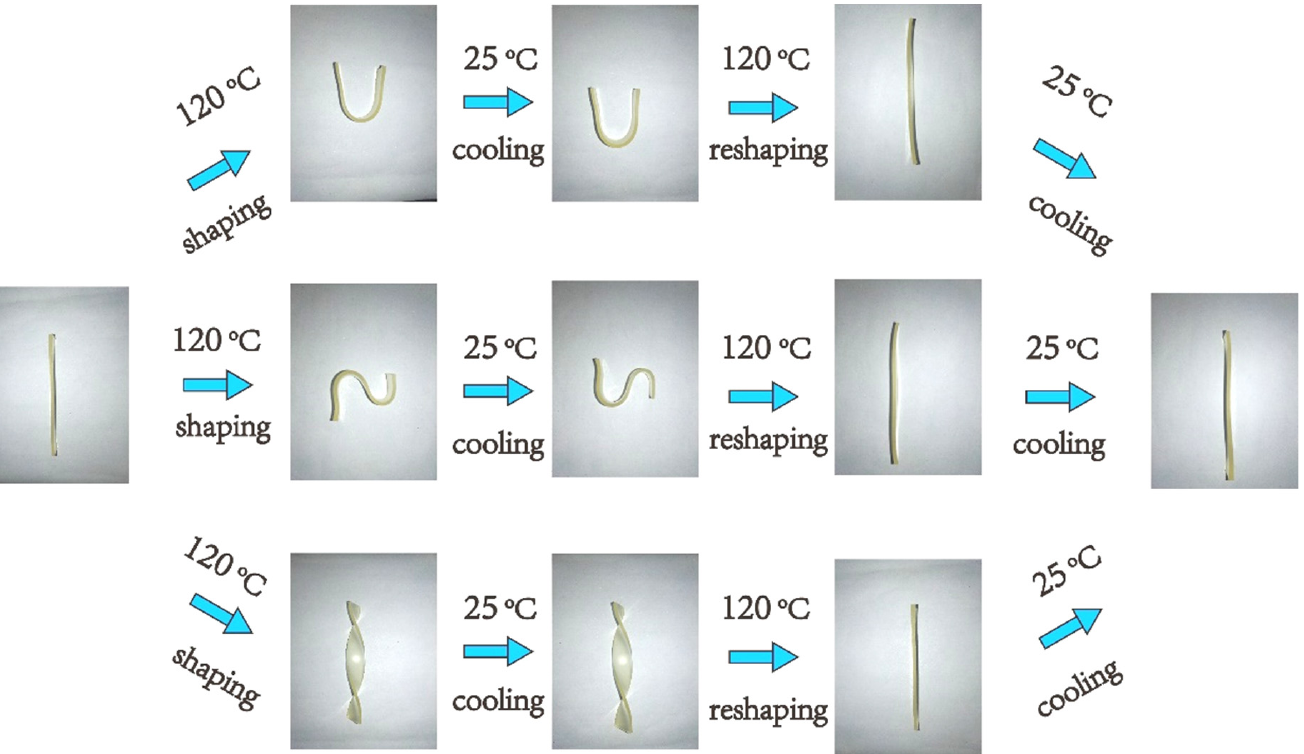
Figure 8. Optical images of the shape-memory performance of 70%VPU OH .